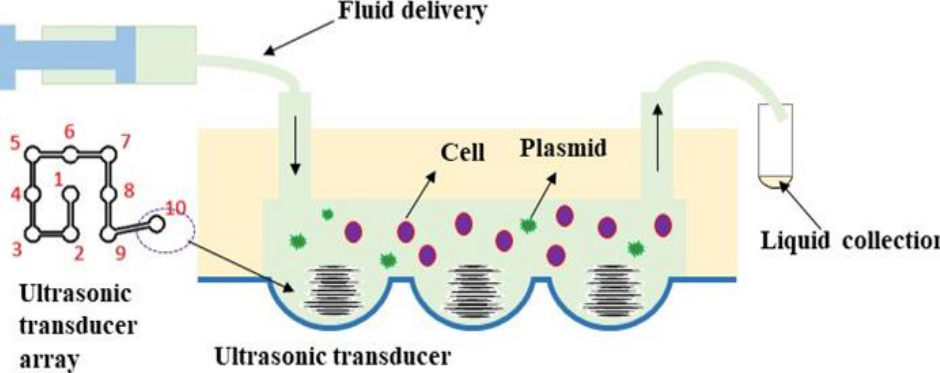
Figure 11. Schematic diagram of the ultrasonic gene transfection experiment. The human renal epithelial cell line (293T cell) was used to prepare single cell sus- pension, and the cells were irradiated with the No. 2 ultrasonic transducer. The effect of ultrasound on cell membrane was evaluated by double staining with the fluorescein diabetic acid (FDA) and propidium iodide (PI). The PI can penetrate the membrane of dam- aged cells and emit red fluorescent light after combining with intracellular DNA. Moreover, active cells emit green fluorescent light with the FDA. As shown in Figure 12, cells only emitting green fluorescence indicate that their cell membranes may not be perforated, while cells only emitting red fluorescence may fail to maintain the integrity of cell membranes due to excessive ultrasonic irradiation, resulting in cell death. If a certain cell emits green and red fluorescent lights after FDA and PI staining, it means that the cell is perforated successfully by ultrasound and the membrane integrity is repair.